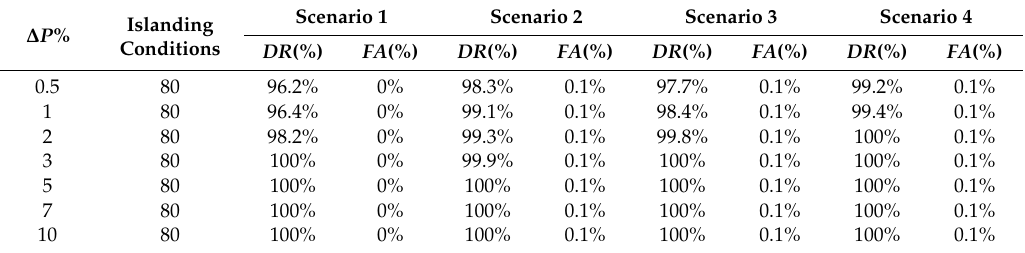
Table 7. Results for testing of di ff erent power imbalances with the trained